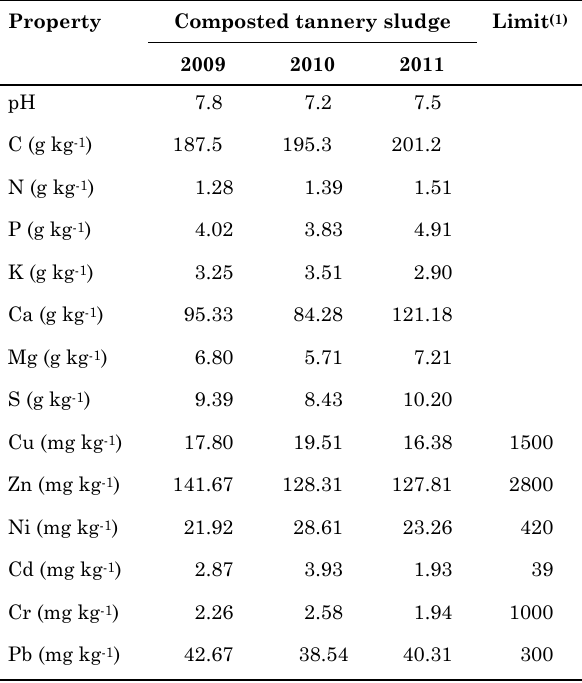
Table 2. Chemical properties of composted tannery sludge (CTS) and the limits permitted for heavy metal (Limit) by National Environment Council (Conama)